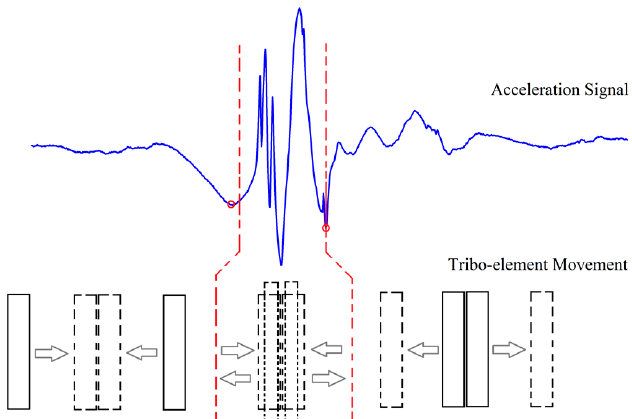
Figure 5. Schematic of the three sessions during tapping.